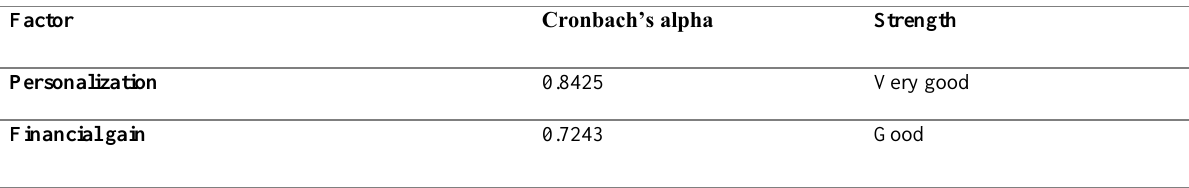
Table 4: Cronbach’s